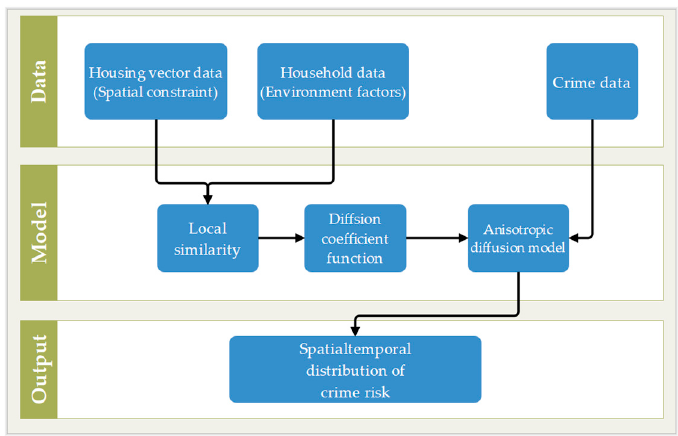
Figure 7. Cumulative crime risk over time.